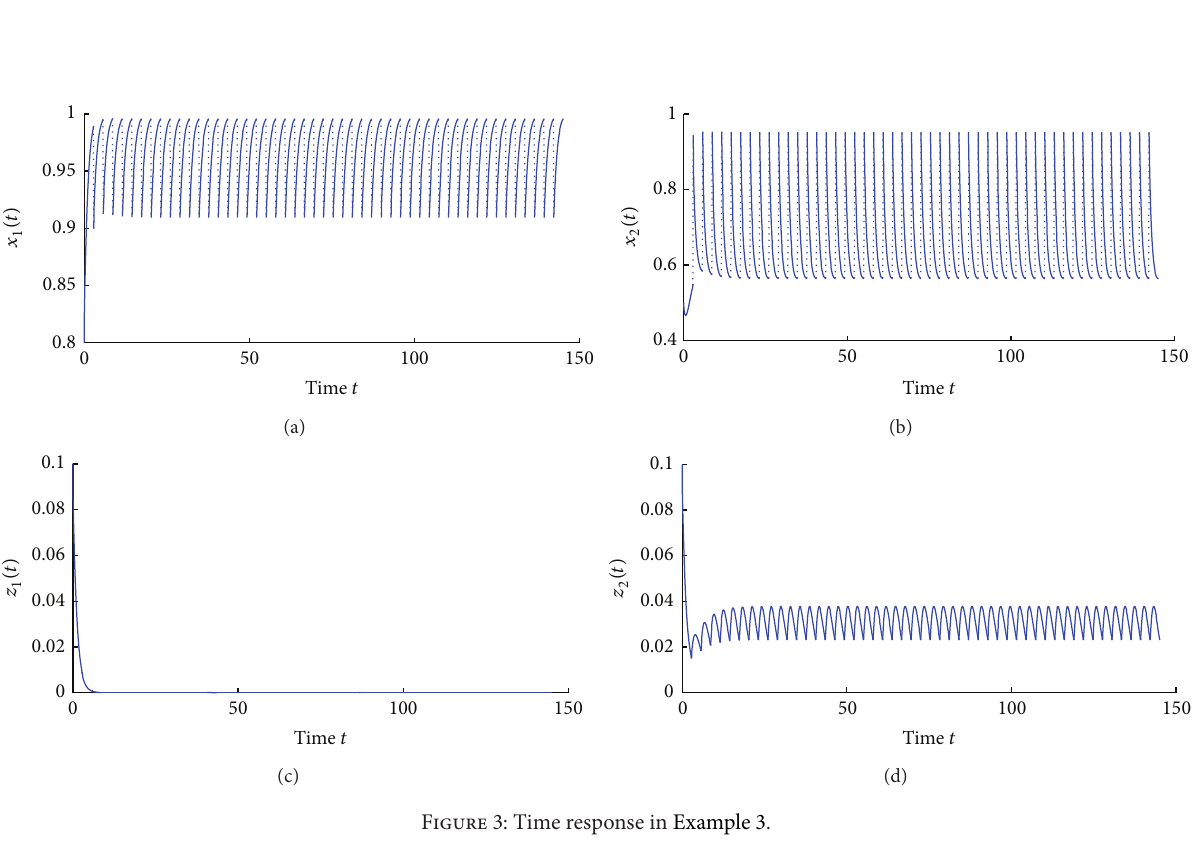
Figure 2: Time response in Example 2.